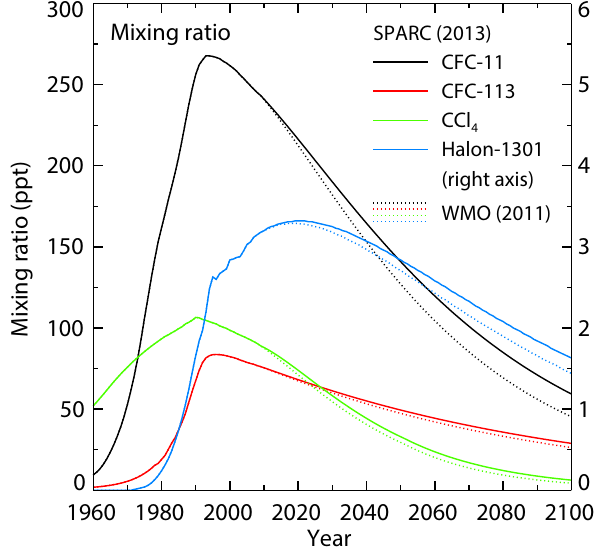
Fig. 1. Mixing ratios based on lifetimes from SPARC (2013) and WMO (2011). The mixing ratios are shown for the ODSs with the most relevant differences in lifetimes for EESC. Before 2010, con- centrations are constrained by observations or are fixed from some other information and so the lifetime differences affect calculated emissions but not